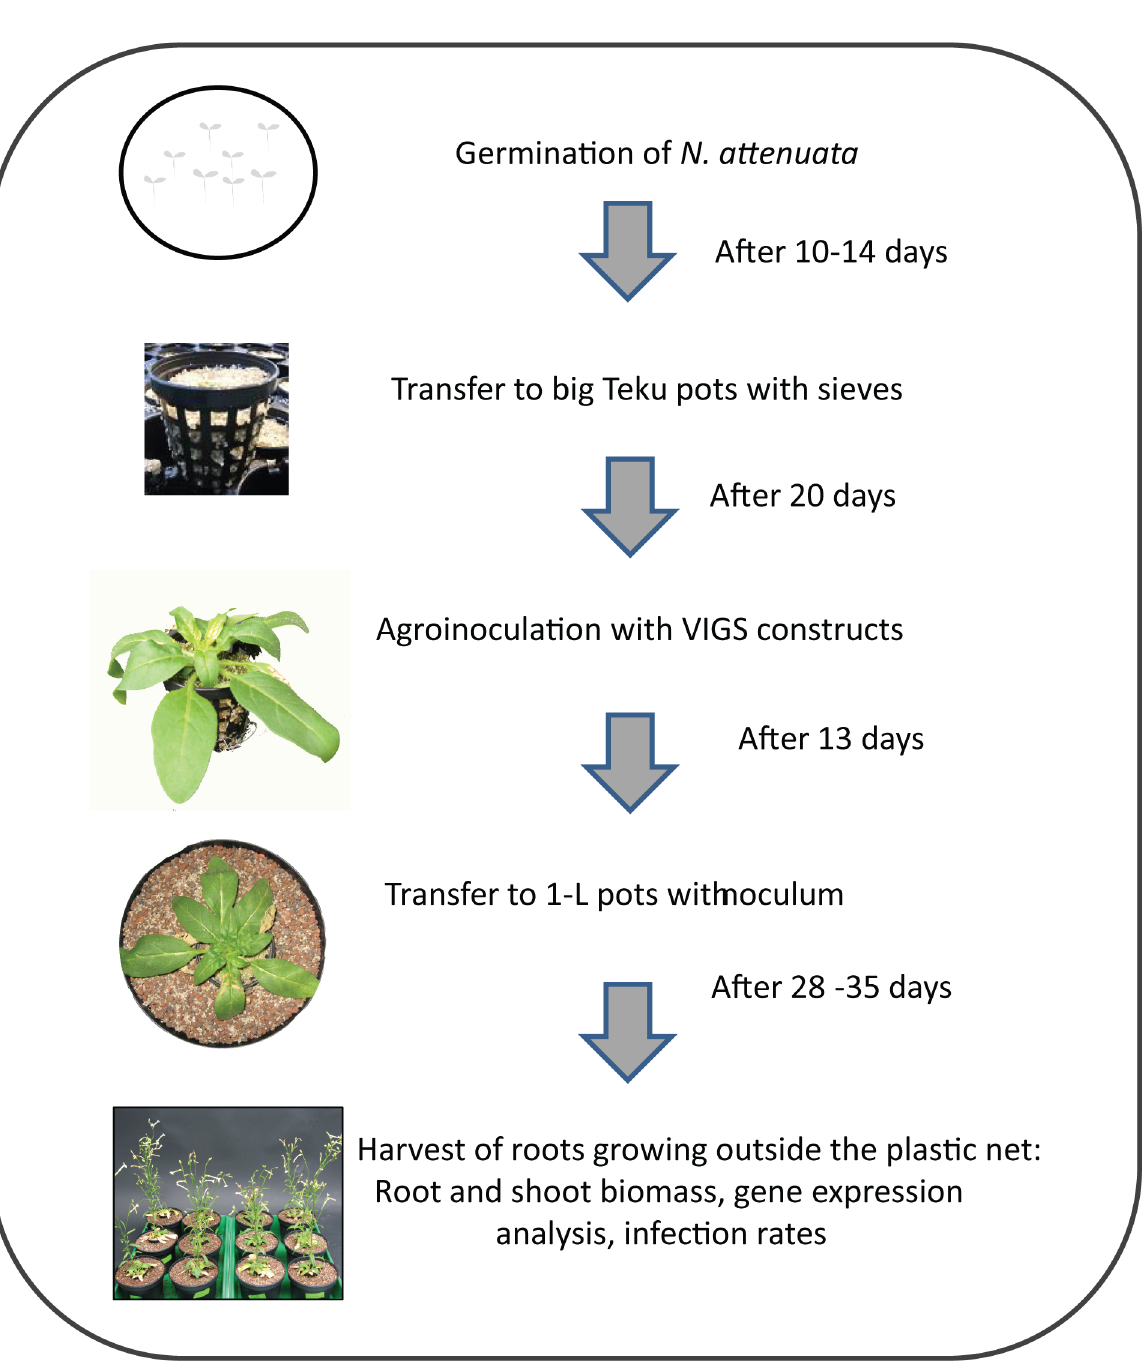
Fig 1. Experimental set-up for virus-induced gene silencing experiments to study the interaction between Nicotiana attenuata and arbuscular mycorrhizal